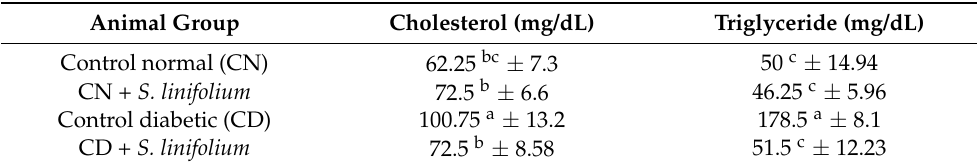
Table 6. Effect of phlorotannin extracts from S. linifolium on serum cholesterol (mg/dL) and serum triglyceride (mg/dL)